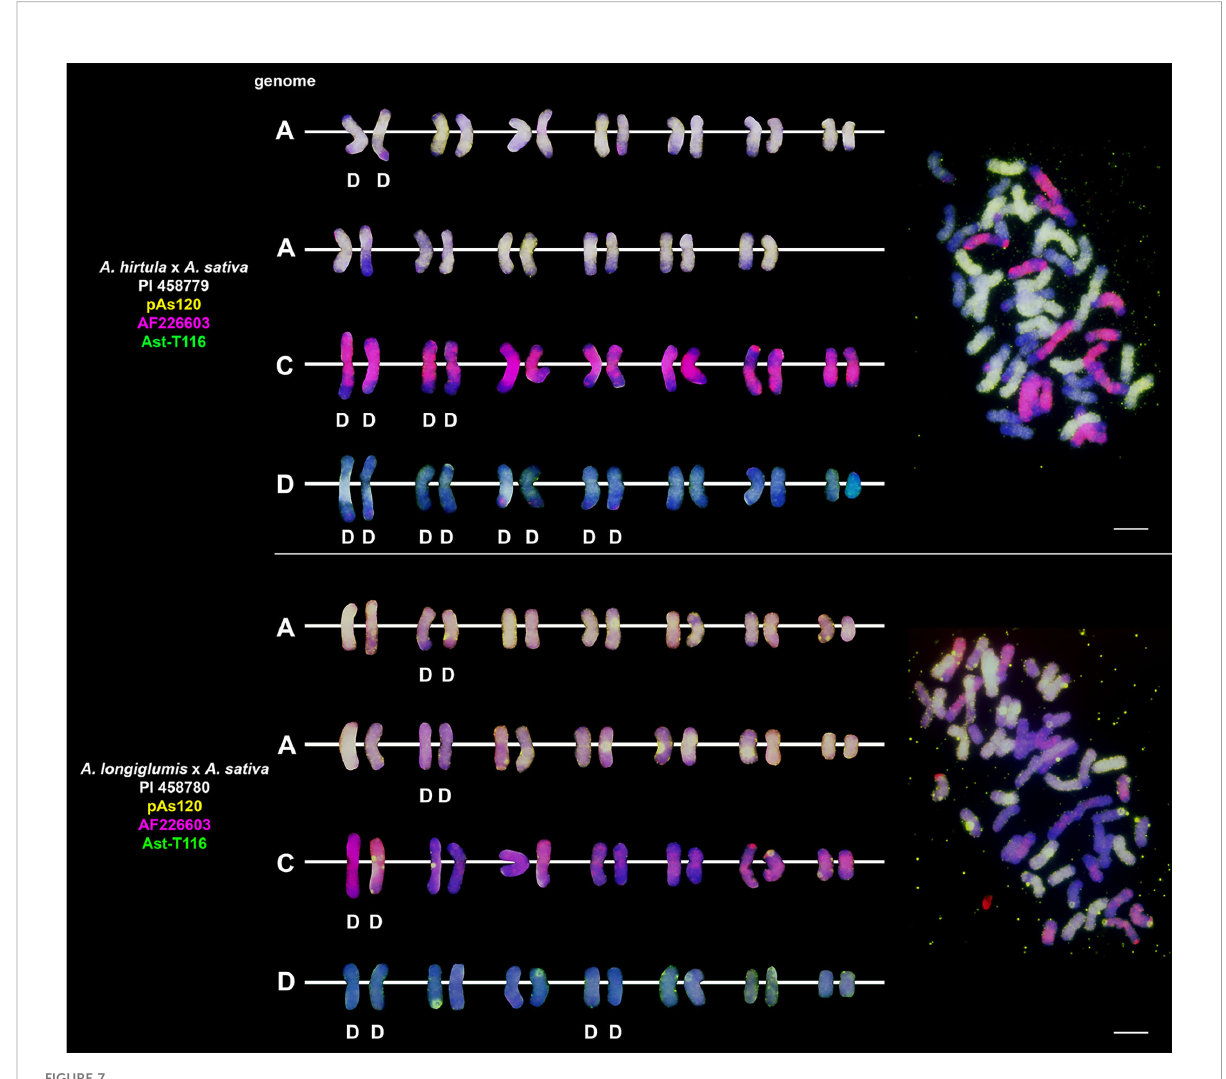
FIGURE 7 Fluorescence in situ hybridization with repetitive DNA probes to chromosomes of amphiploids formed by crossing diploid species having AA genomes with A. sativa . Intergenomic translocations were visualized. D- distal translocation. Scale bar = 10 m